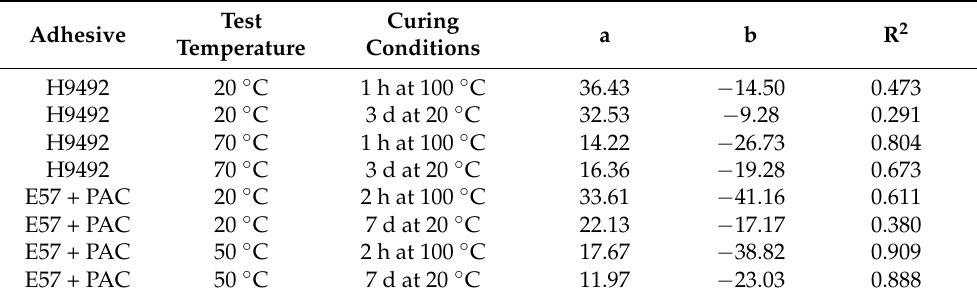
Table 5. Fitting the strength variation curve against the inaccuracy of the adhesive preparation to the linear model: Strength = a + b · (inaccuracy).